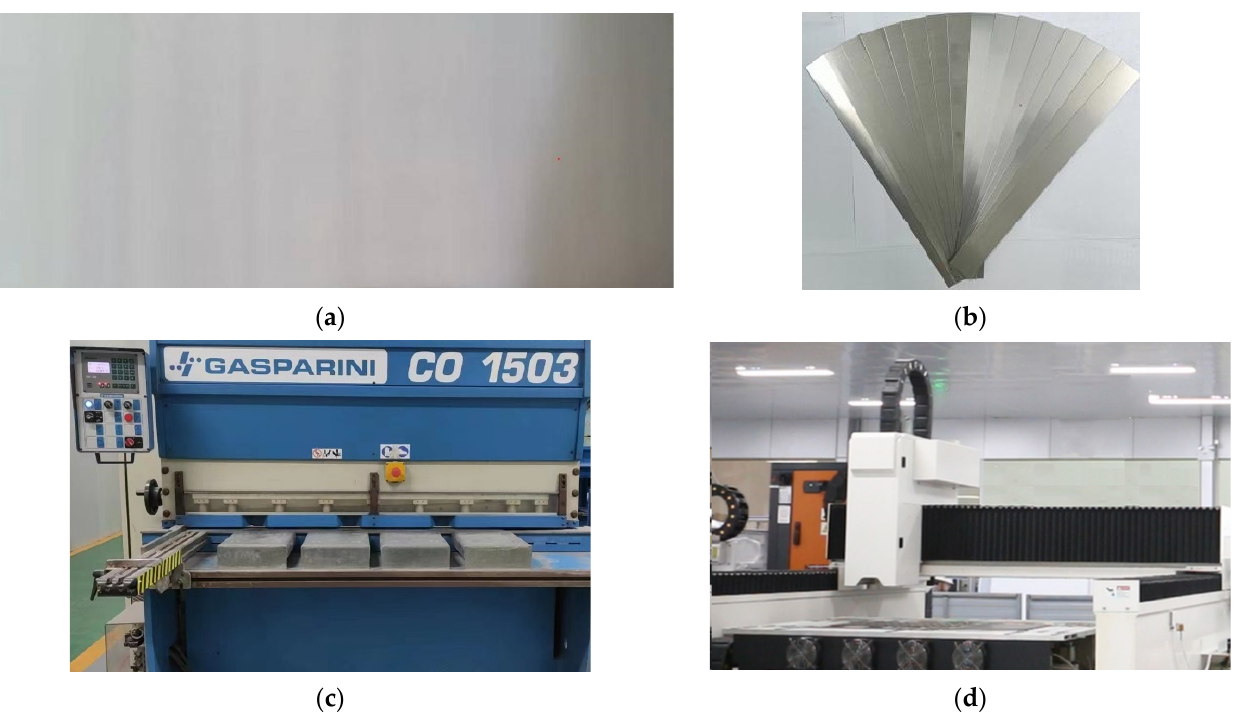
Figure 1. Samples and mechanic shearing/laser cutting system. ( a ) Steel sheet before cutting (400 mm × 1100 mm × 0.5 mm); ( b ) Samples after cutting (320 mm × 30 mm × 0.5 mm); ( c ) Mechanic shearing system; ( d ) Laser cutting system.